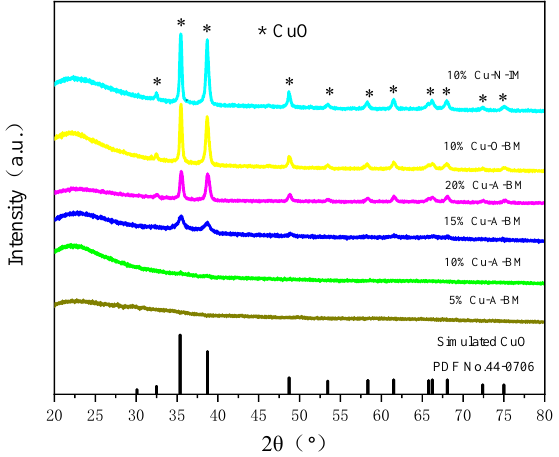
Figure 2. XRD patterns of W%Cu-A-BM, 10%Cu-O-BM, 10%Cu-N-IM catalysts calcined at 500 °C.